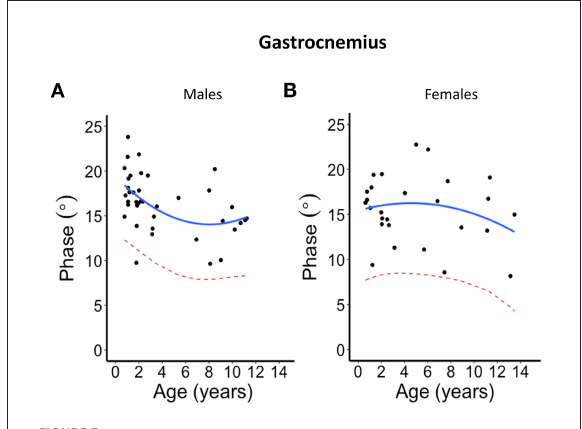
FIGURE3 Phase angle values at 100kHz made on gastrocnemius muscle for (A) males and (B) females. The blue solid line represents the normal fit generated from the second-degree polynomial regression through the log-transformed data while the red dotted lines represent the parallel curve that is the lower limit of normal based on the 95% prediction limit of the quadrative curve.